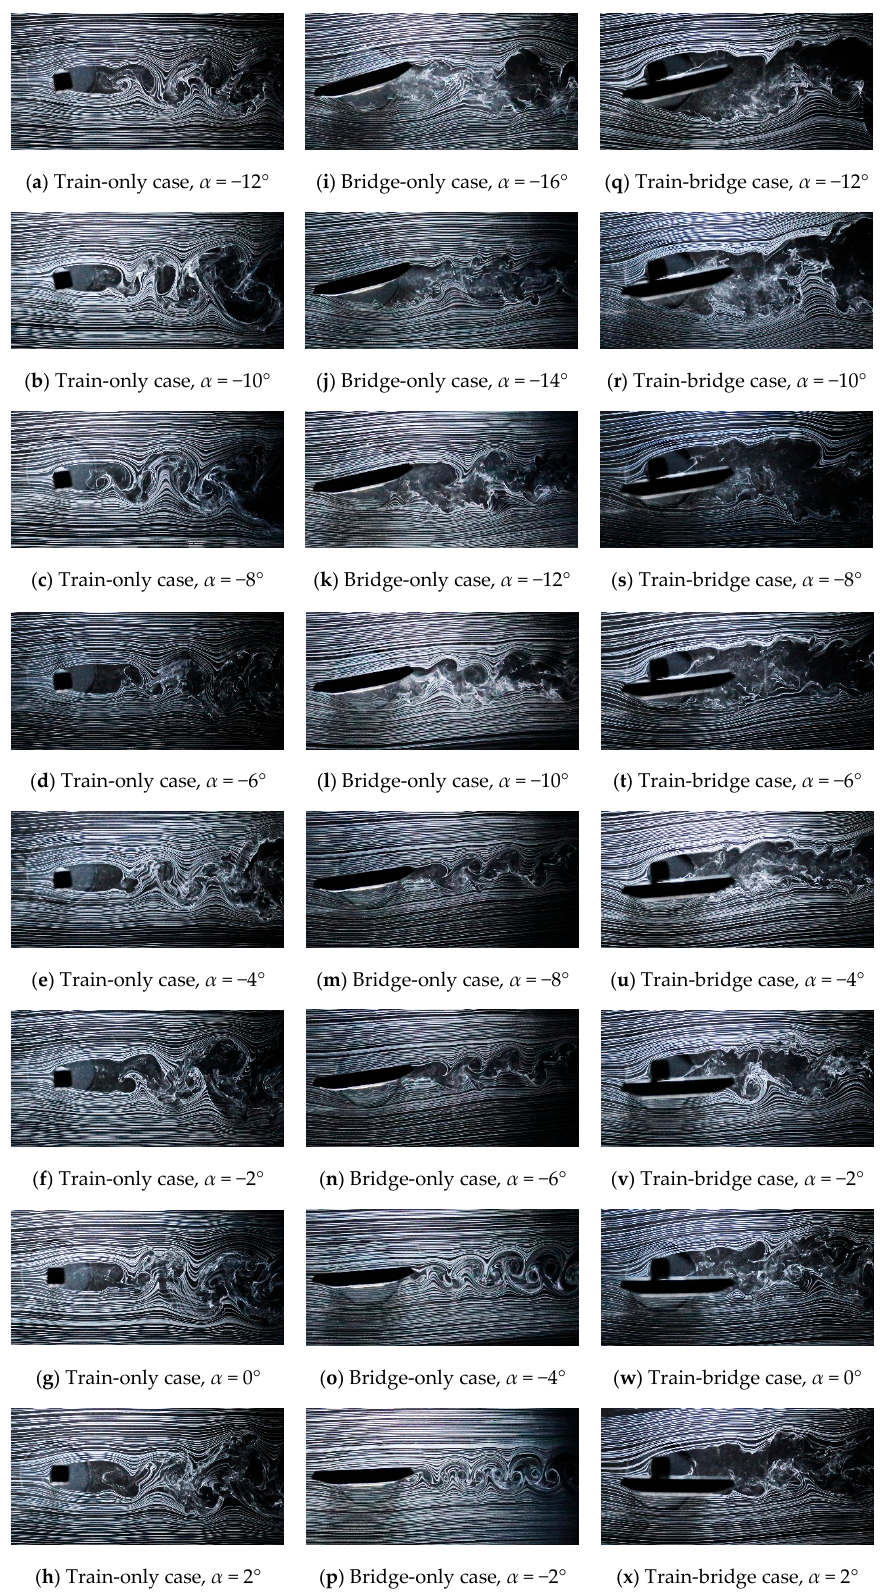
Figure 3. Instantaneous flow patterns: ( a – h ) Train-only case at α = − 12°~2°, ( i – p ) Bridge-only case at α = − 12°~2°, and ( q – x ) Train-bridge case at α = − 16°~ − 2°.